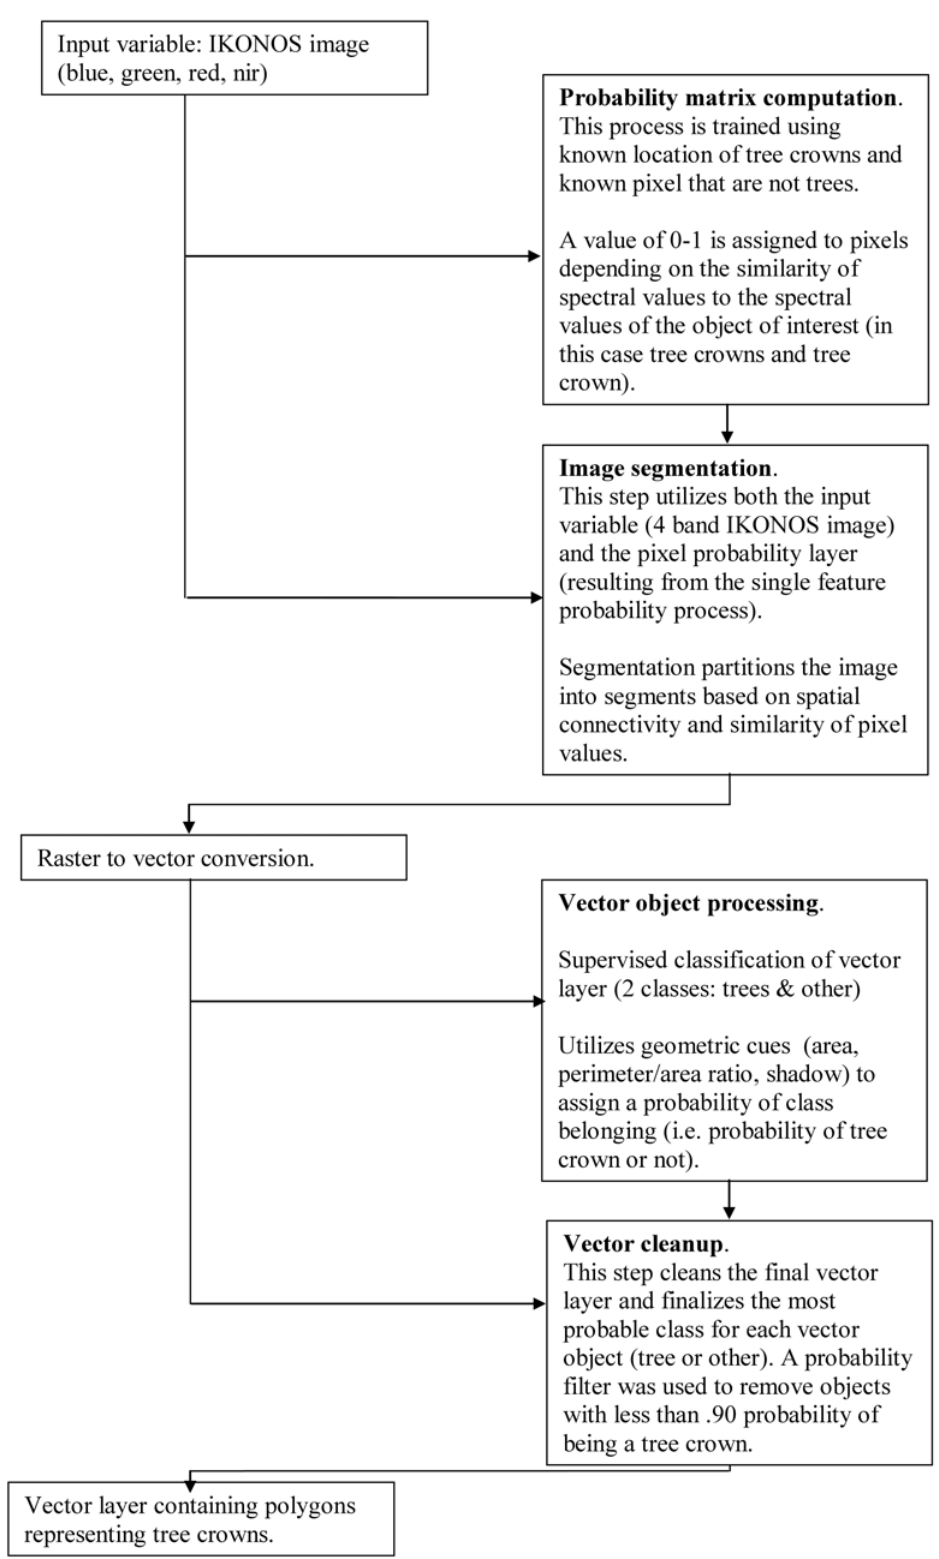
Figure 3 . Object based classification